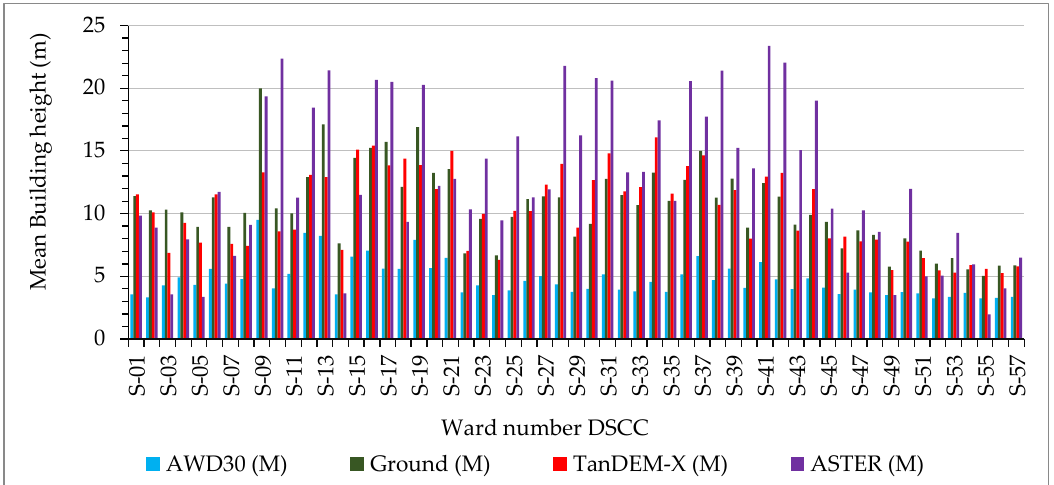
Figure 7. Ward-wise (small administrative boundary) mean building height of Dhaka South City Corporation (DSCC).